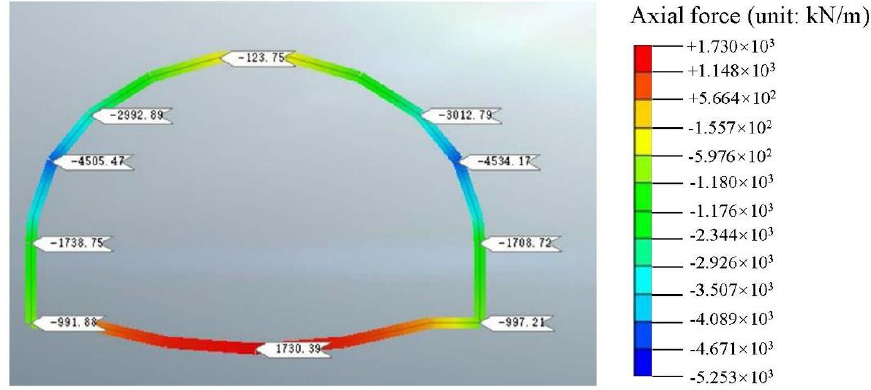
Figure 20. Axial force diagram of each node of the initial support after treatment.